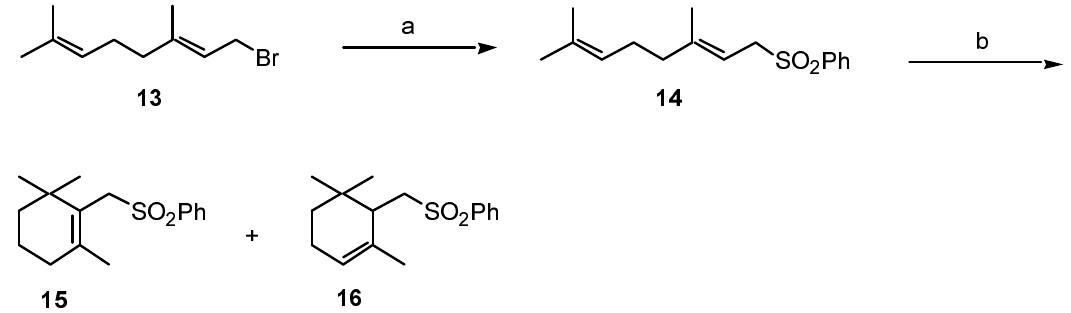
Figure 6. Synthesis of sulfones 15 and 16 from geranylbromide 13 . Reagents: (a) PhSO 0°C, 1 hour (80%). (b) H